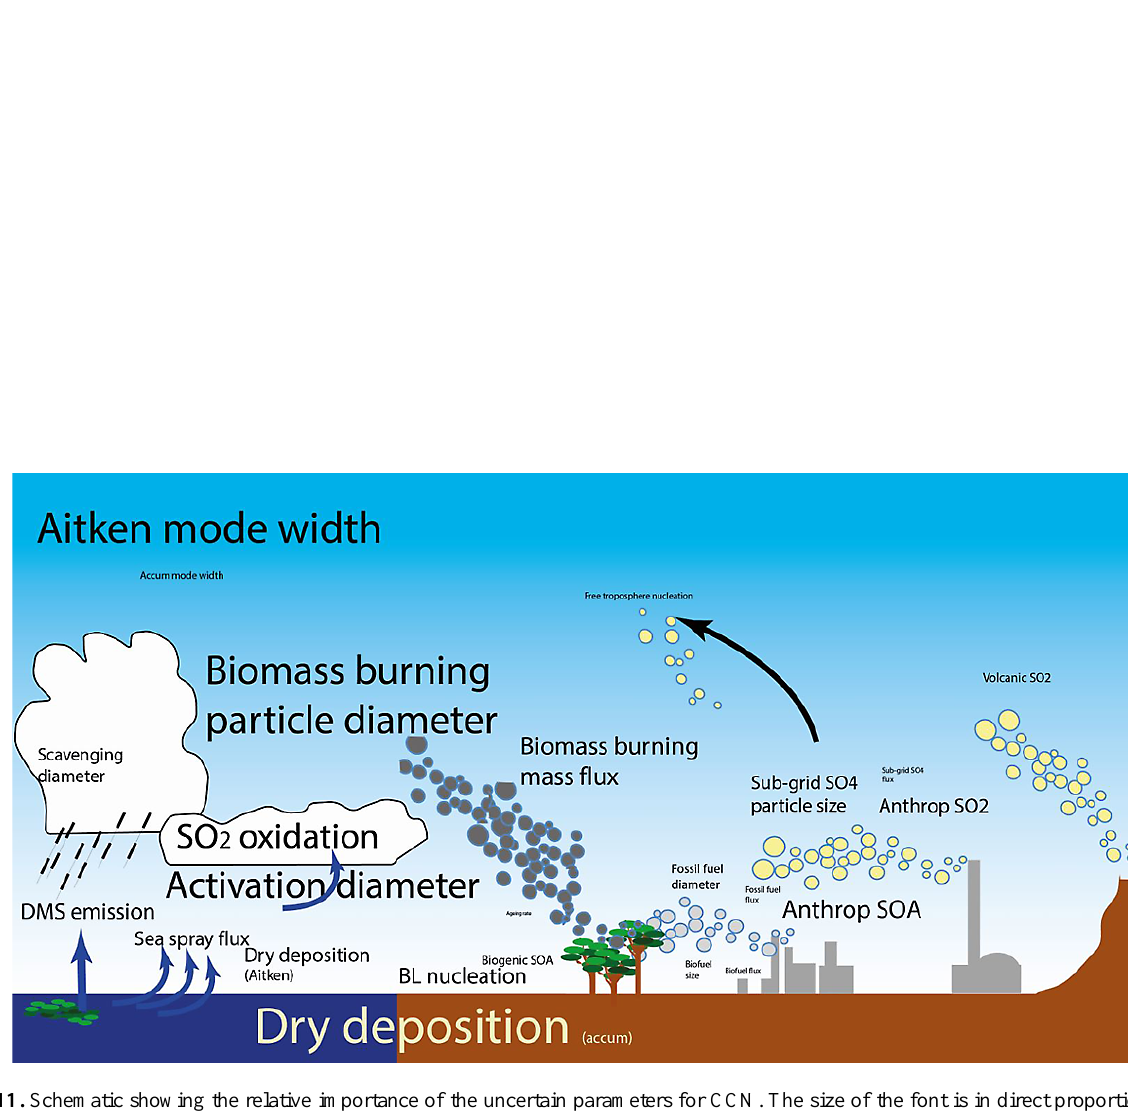
Fig. 11. Schematic showing the relative importance of the uncertain parameters for CCN. The size of the font is in direct proportion to the global and annual mean relative